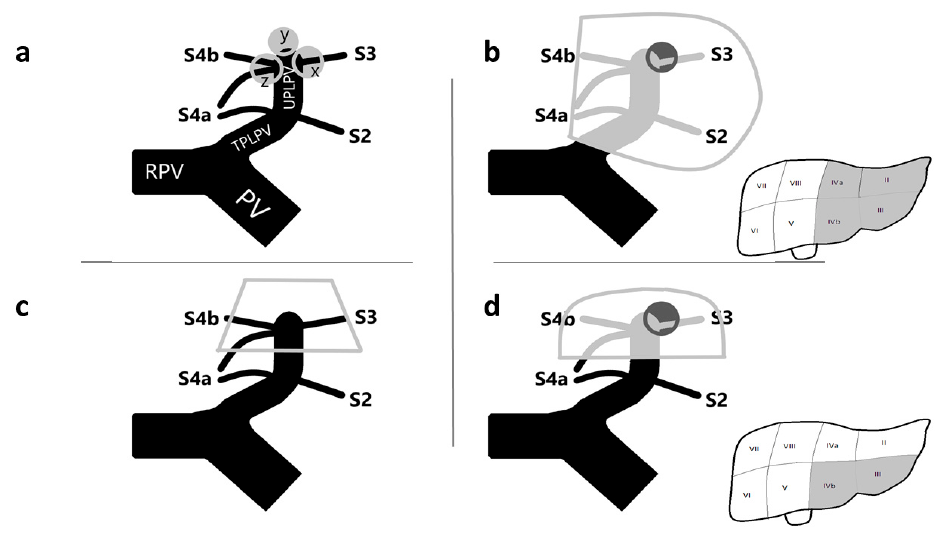
Figure 1. Surgical management of tumors invading the distal part of the UPLPV. ( a ) Different types of tumors invading the UPLPV; “y” invades the tip of the UPLPV; “x” and “z” invade the UPLPV and the origin of the portal pedicles for S3 and S4b, respectively. ( b ) A schematic illustration of the left hemi-hepatectomy for a tumor invading the UPLPV at the origin of the portal pedicle for S3; the portal branches (bigger picture on the left) and the portion of parenchima (smaller picture on the right) to be removed during left hepatectomy are represented in grey. ( c ) The grey line delimits the LAS, an independent anatomo/functional unit corresponding to the anterior portion of the left hemiliver including S3 and S4b inferior; it is supplied by an independent sectorial portal pedicle represented by the distal part of the UPLPV downstream from the origin of independent portal pedicles for left posterior segments (S2 and S4a). ( d ) A schematic illustration of the left anterior sectorectomy for a tumor invading the UPLPV at the origin of the portal pedicle for S3; the portal branches (bigger picture on the left) and the portion of parenchima (smaller picture on the right) to be removed during left anterior sectorectomy are represented in grey. (PV, portal vein; RPV, right portal vein; TPLPV, transverse portion of the left portal vein; UPLPV, umbilical portion of the left portal vein; LAS, left anterior sector; S2, segment 2; S3, segment 3; S4a, segment 4 superior; S4b, segment 4 inferior).